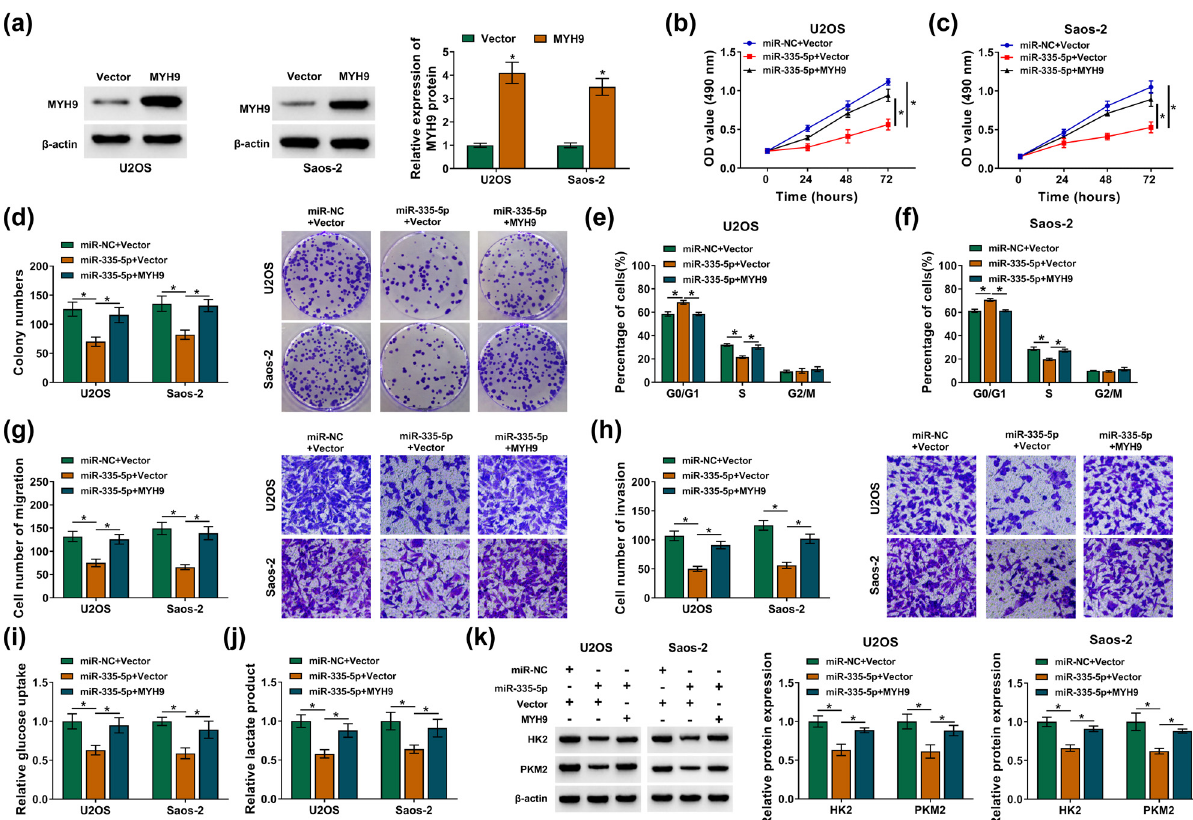
Figure 6: MiR - 335 - 5p targeted MYH9 to inhibit OS cell malignancy and glycolysis. ( a ) The overexpression e ffi ciency of MYH9 in OS cells was detected by Western blotting. ( b – k ) OS cells were transfected with miR - NC + vector, miR - 335 - 5p + vector, or miR - 335 - 5p + MYH9. ( b – h ) The proliferation, cell cycle progression, migration, and invasion of OS cells were evaluated by MTT, plate clone, fl ow cytometry, and transwell assays, respectively. ( i and j ) Detection of glucose uptake and lactate product levels in OS cells. ( k ) Analysis of HK2 and PKM2 protein levels in U2OS and Saos - 2 cells by Western blotting. * P <